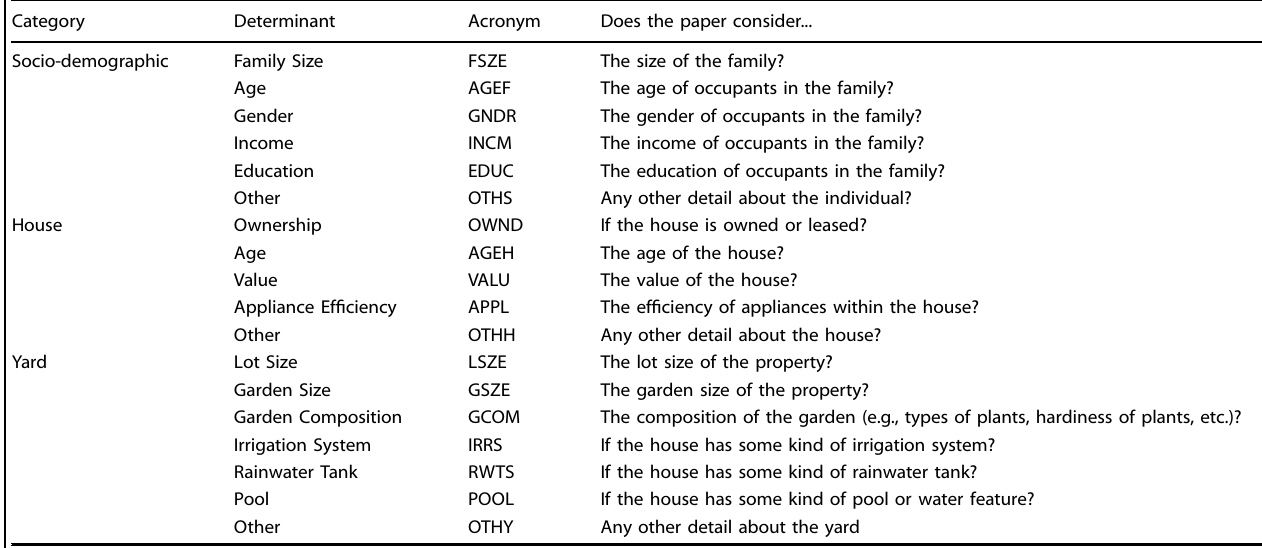
Table 1. Sub-categories and determinants classi fi ed as observable.